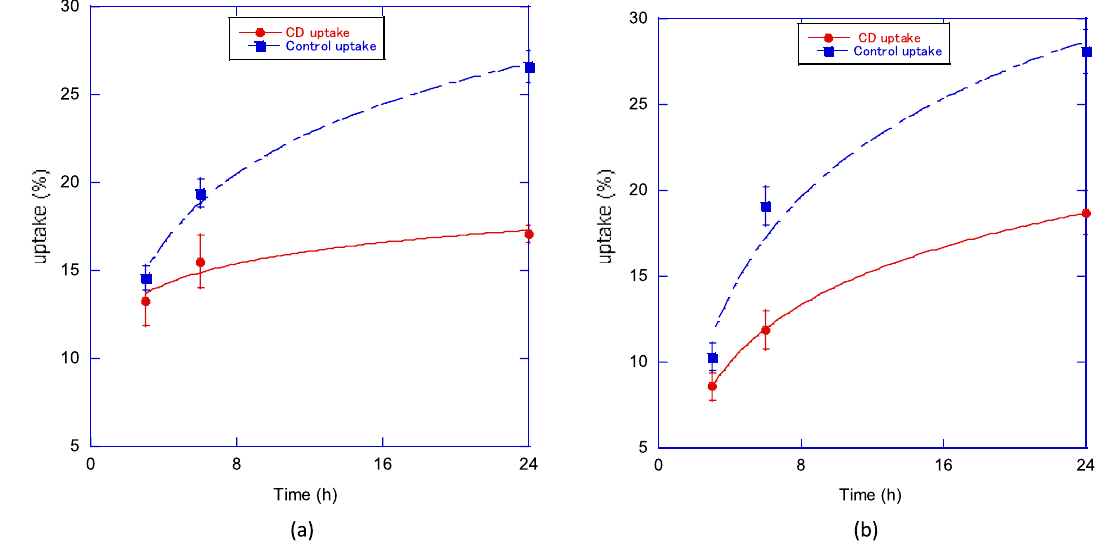
Figure 4. Changes in thyroid uptake values in the ( a ) Na 123 I + α-CD-administration and control groups, and ( b ) Na 131 I + α-CD-administration and control groups.